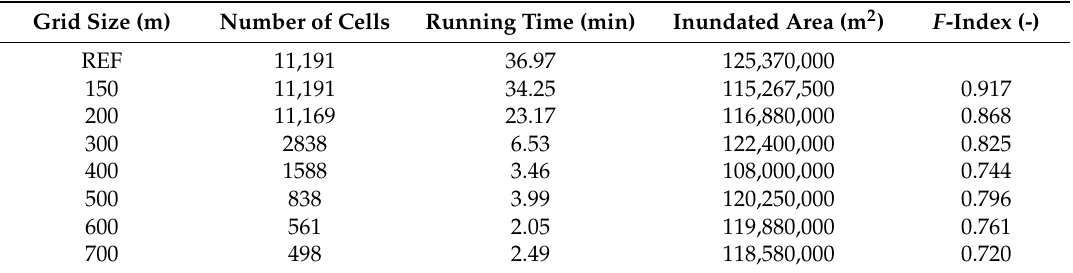
Table 1. Performance metrics of running time, maximum simulated inundated area and F -index comparing reference model with upscaled flood models at different DTM